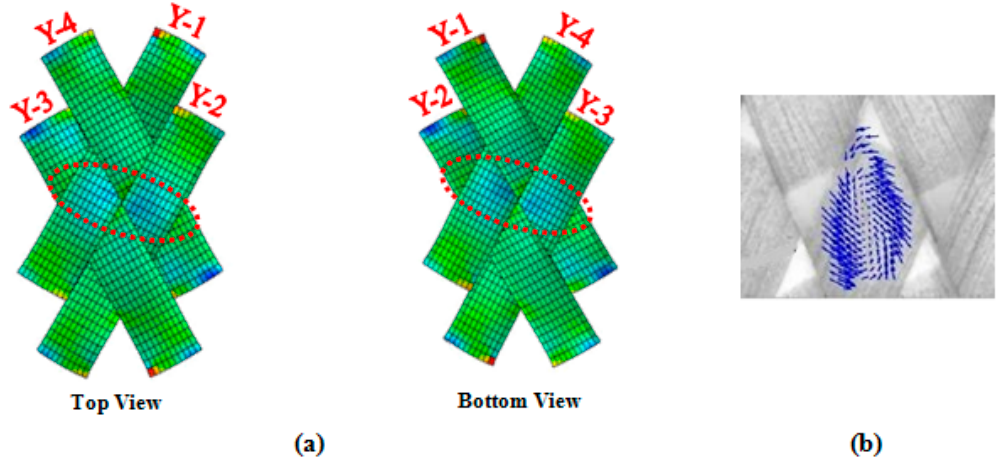
Figure 4. Compressive forces induced between adjacent yarns during in-plane shear deformation of PWCP ( a ) simulation; ( b ) experimental investigation of the yarn strain field in large shear deformation [3].